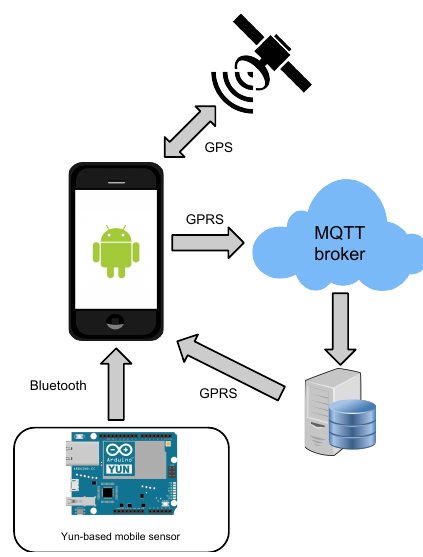
Figure 4. Android App schema.